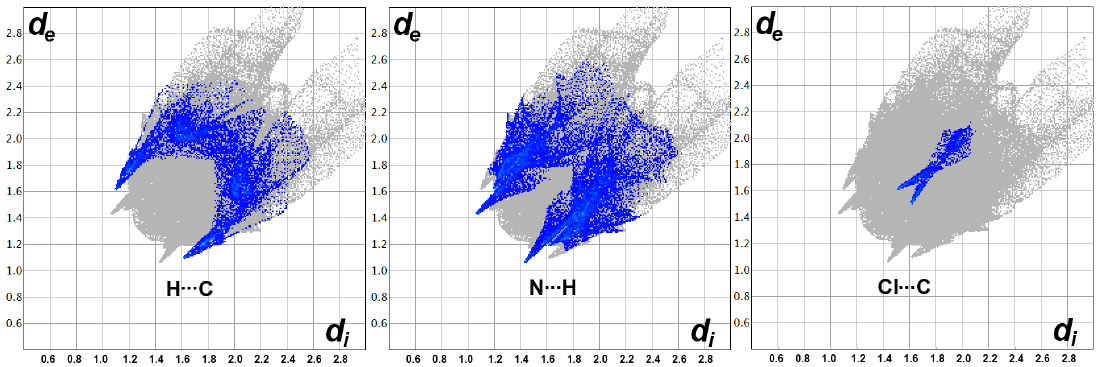
Figure 6. The possible intermolecular contacts and their percentages in the trinuclear Zn(II) complex.